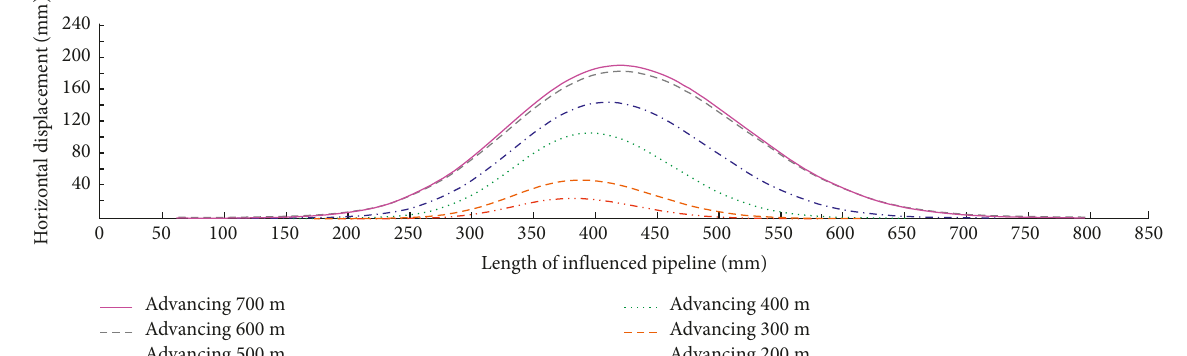
Figure 10: Surface subsidence along the pipeline.